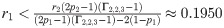
Selection for stepwise de-differentiation when the effective rate of self renewal is highest in compartment 2.Illustration of the selection gradient (comparative fitness) of the S mutant cell population ΔλS as a function of redistributing factor and division rates provided that λ0 = r2(p2 − q2). In both panels, colored lines represent the eigenvalue perturbation results from Eq (8) and symbols represent exact numerical solutions. The common parameters are n = 4, ρ = 0.01, d = 0.05. (a) Expanding case (λ0 > 0). In this case, there are two different scenarios: For r1<r2(2p2-1)(Γ2,2,3-1)(2p1-1)(Γ2,2,3-1)-2(1-p1)≈0.1950, ΔλS is always positive (blue color); For r1 > 0.1950, ΔλS changes from positive to negative with the increase of κ (red color). Here p1 = 0.5, p2 = 0.95, p3 = 0.55, r2 = 0.44, and r3 = 0.17. (b) Homeostasis case (λ0 = 0). In this case, ΔλS is always positive. Here p1 = 0.001, p2 = 0.5, p3 = 0.001, r1 = 0.99, and r3 = 0.8.